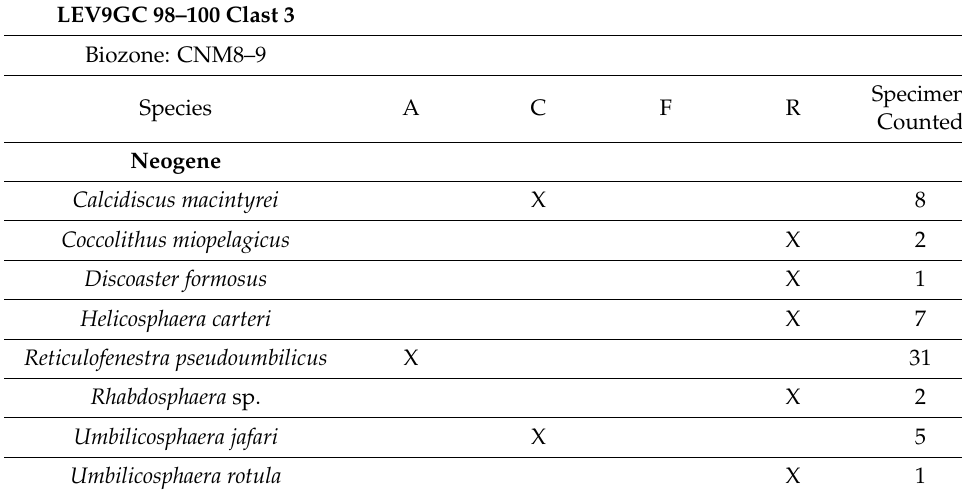
Table A43. Leipzig